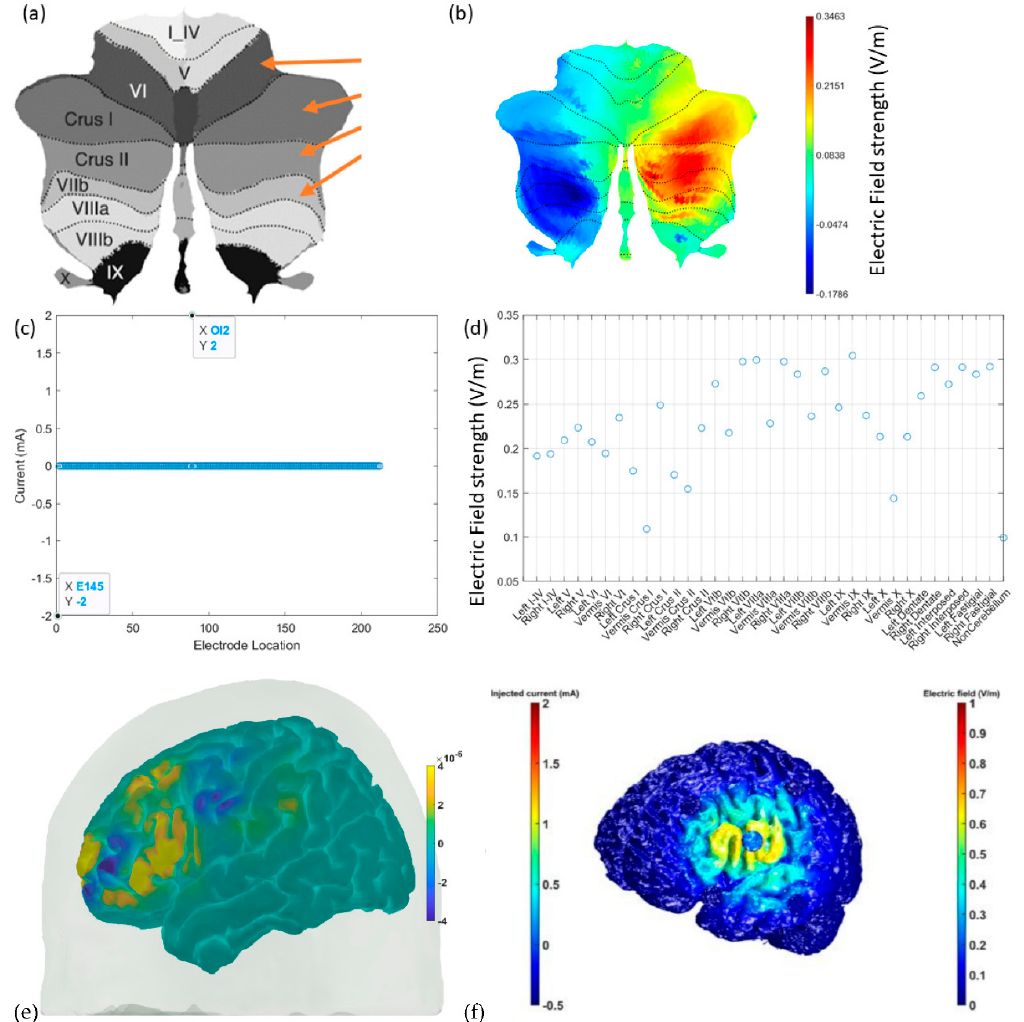
Figure 8. ( a ) A spatially unbiased atlas template (SUIT) of the human cerebellum and the ctDCS/ctACS targets shown with orange arrows for the cerebellar lobule’s optimal stimulation (CLOS). ( b ) The electric field (V/m) strength in SUIT results from CLOS. ( c ) Electrode location results from CLOS for 2 mA ctDCS/ctACS. ( d ) The cerebellar lobular and subsectional electric field (V/m) results from CLOS. ( e ) fNIRS HbO (in M) brain activation at the inferior frontal gyrus, which can be targeted with HD-tDCS. ( f ) HD-tDCS montage to facilitate downstream inhibition from the subthalamic nucleus when substance-associated cues trigger